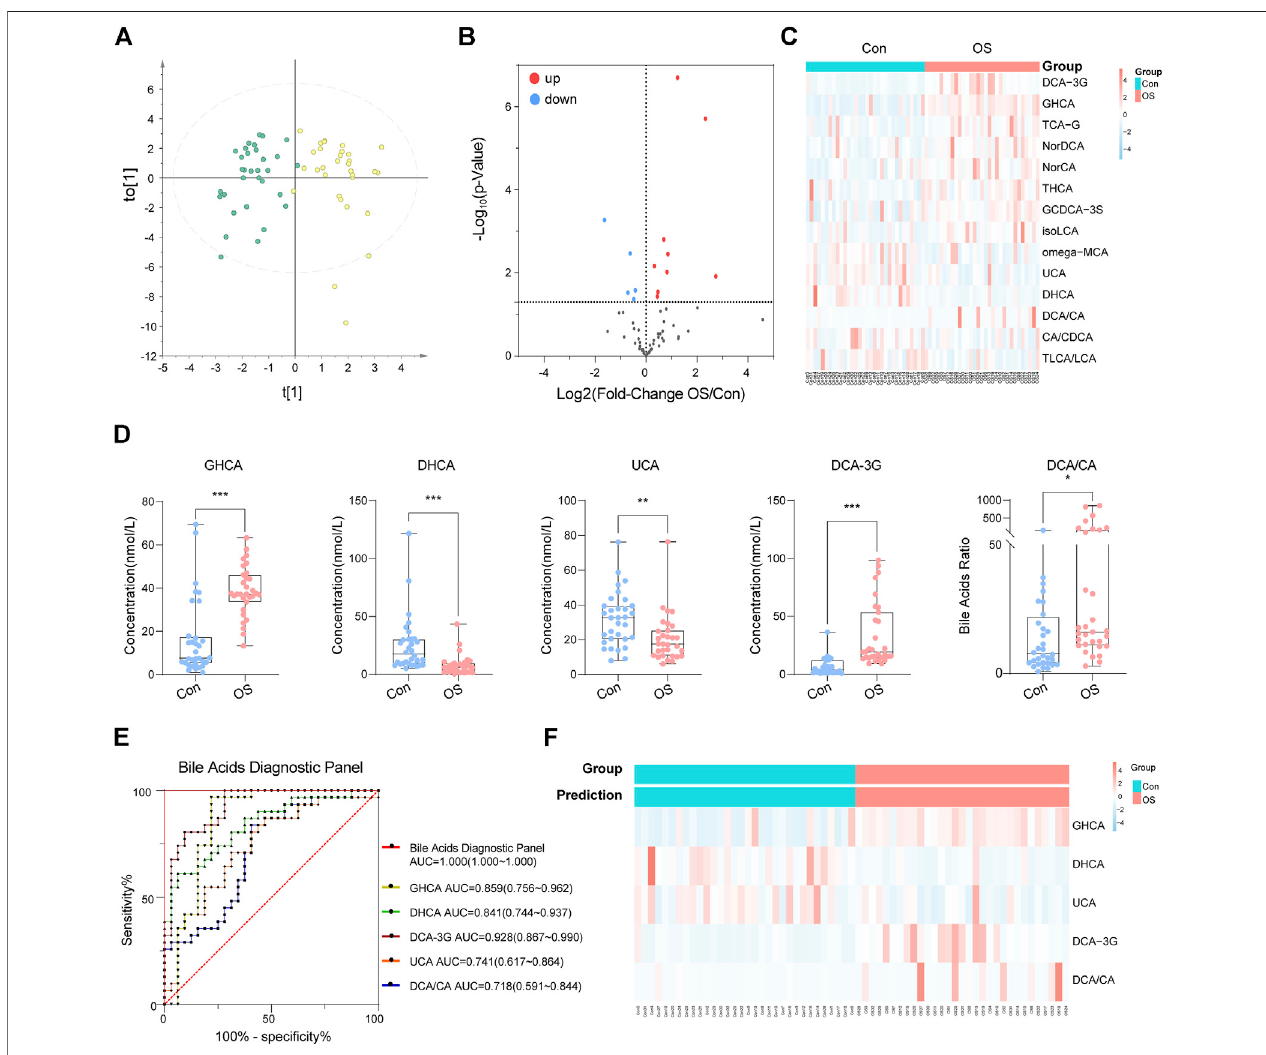
FIGURE 4 | OPLS-DA plot of absolute quantitation of BAs (A) . Volcano plot of absolute quantitation of BAs (B) . Heatmap of selected BAs that were signi fi cantly changedinthevolcanoplot (C) .Afteranalysisbybinarylogicregression, fi veBAbiomarkerswerevisualizedintheformofboxplots (D) .TheROCcurveoftheabove fi ve biomarkers and the diagnostic panel (E) . The prediction accuracy of the diagnostic panel is shown by a heatmap (F) .